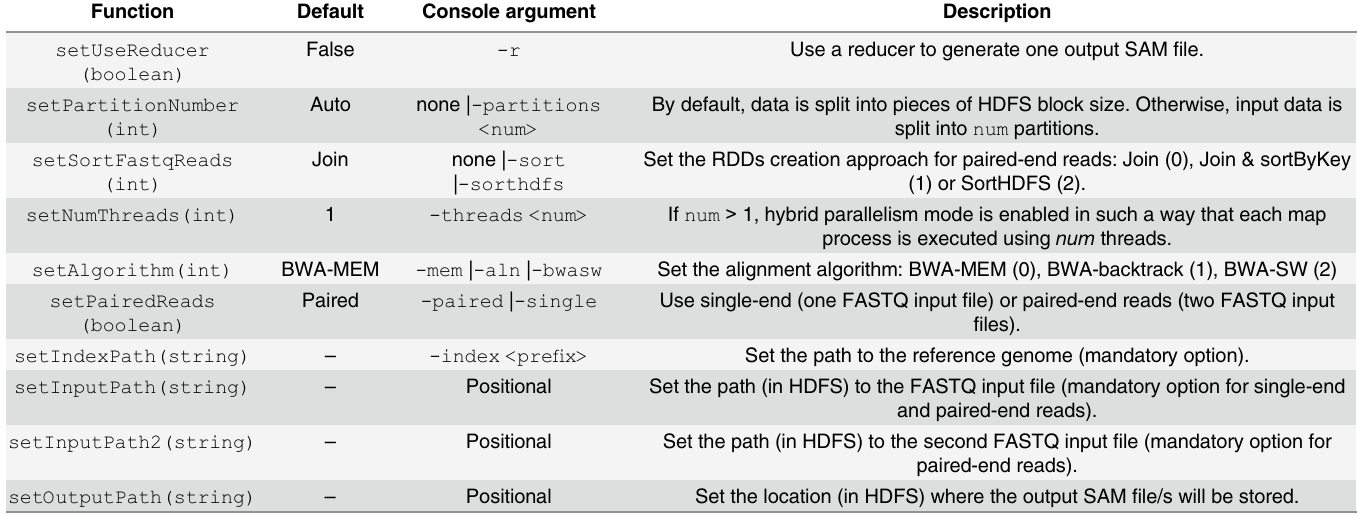
Table 1. API methods and console arguments to set the SparkBWA